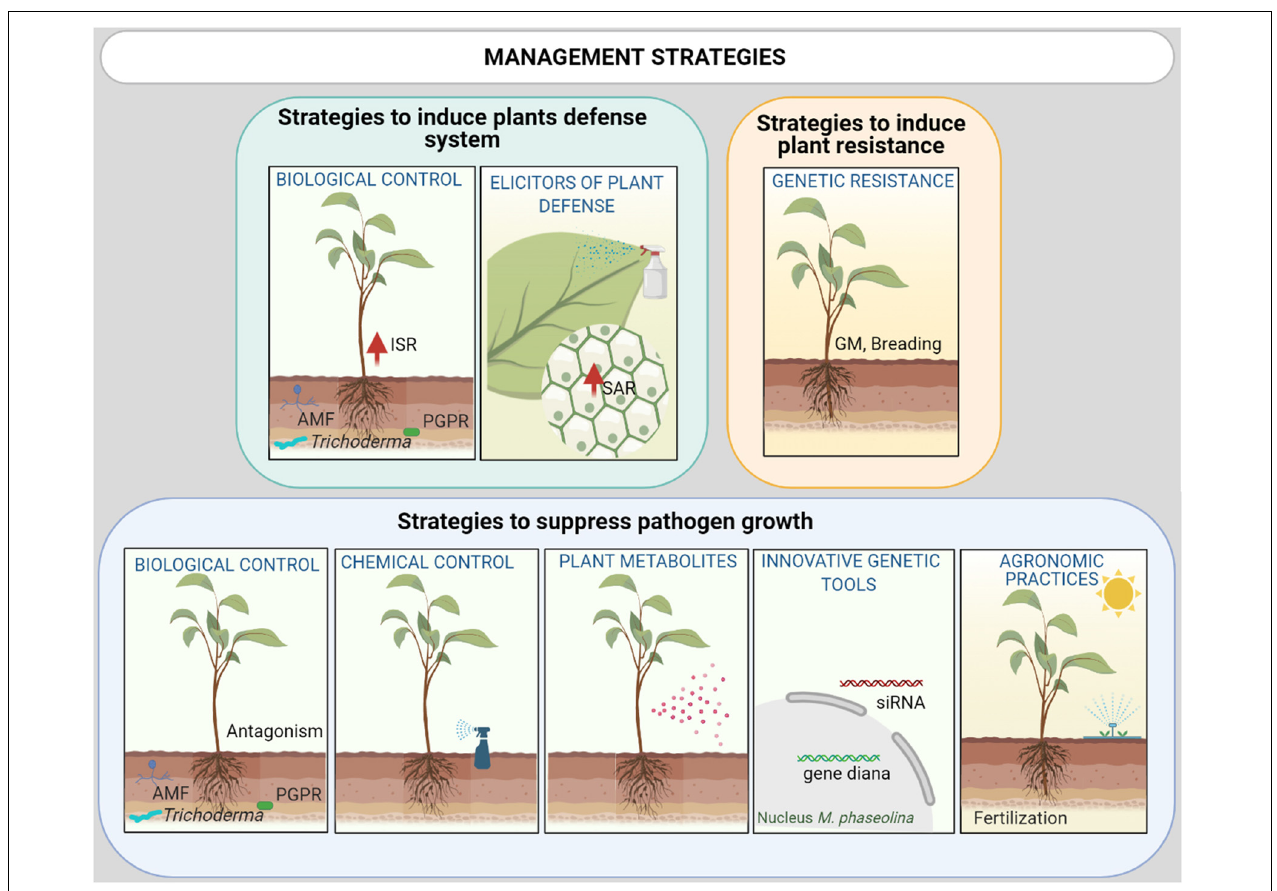
FIGURE 4 | Integrated M. phaseolina disease management strategies could include a combination of: (i) Promotion of plant defense response with selected Biological control agents (BCAs) and natural or chemical elicitors via induced systemic resistance (ISR) or systemic acquired resistance (SAR), respectively; (ii) Host genetic resistance [via breeding or GM (genetic modification)]; (iii) Reduction of the inoculum density and growth via agricultural practices (biosolarization, irrigation), plant metabolites with allelopathic activity, BCAs, innovative genetic tools as Small interfering RNA (siRNA) molecules and chemical control using nanoformulation of fungicide with low collateral damage to surrounding